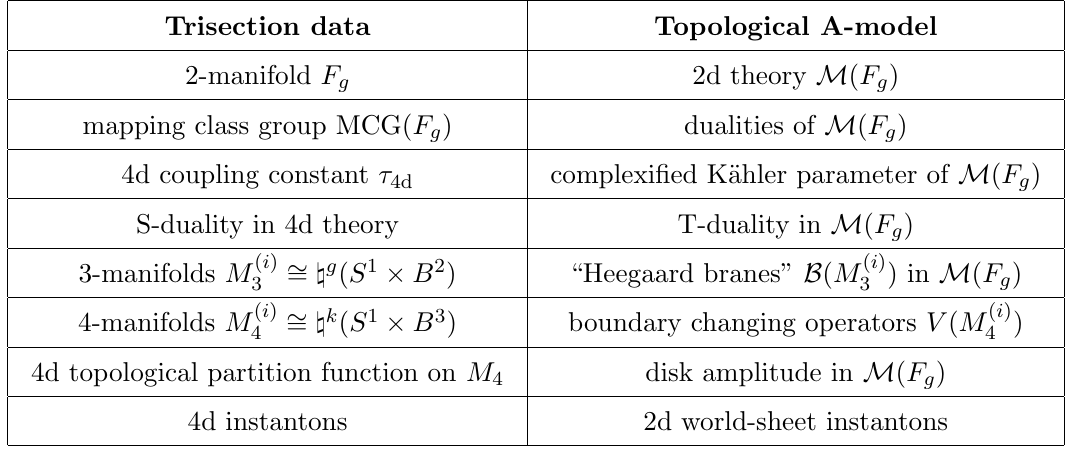
Table 1 . The dictionary between geometry and